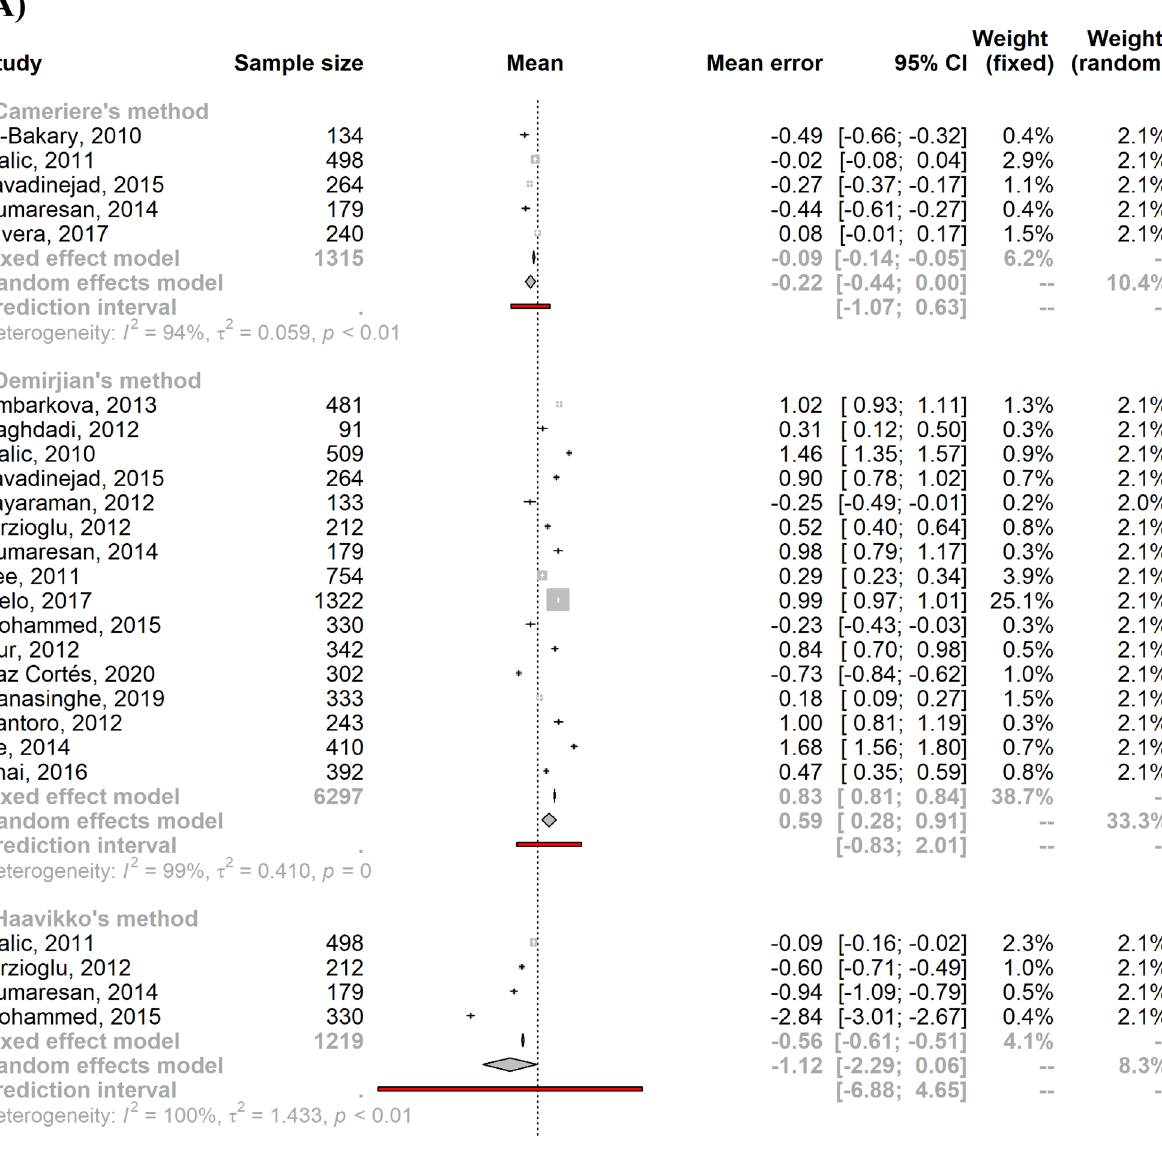
Figure 3. Forest plots showing the pooled mean errors of the age predictions for males ( A ) and females ( B ) by method of age